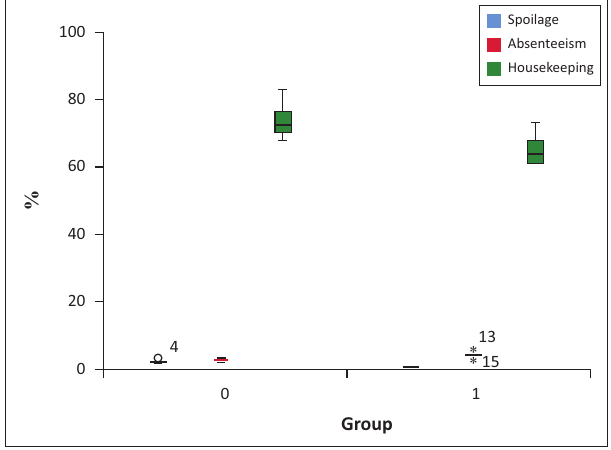
FIGURE 2: Box plots determining the normality and homogeneity of